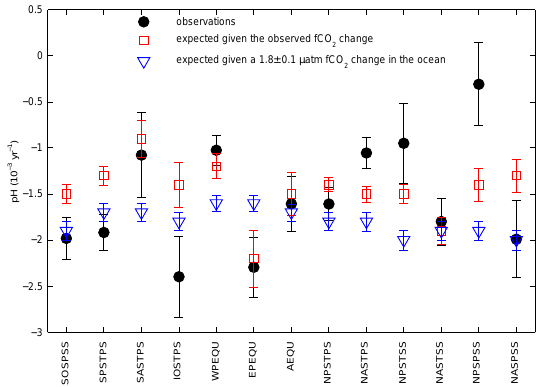
Figure 6. Comparison between the observed pH trend in each biome (either 1981–2011 or 1991–2011) in black, and the pH trends expected if the surface ocean f CO 2 change were equal to that the atmosphere in blue and expected for the observed ocean f CO 2 trends in red.